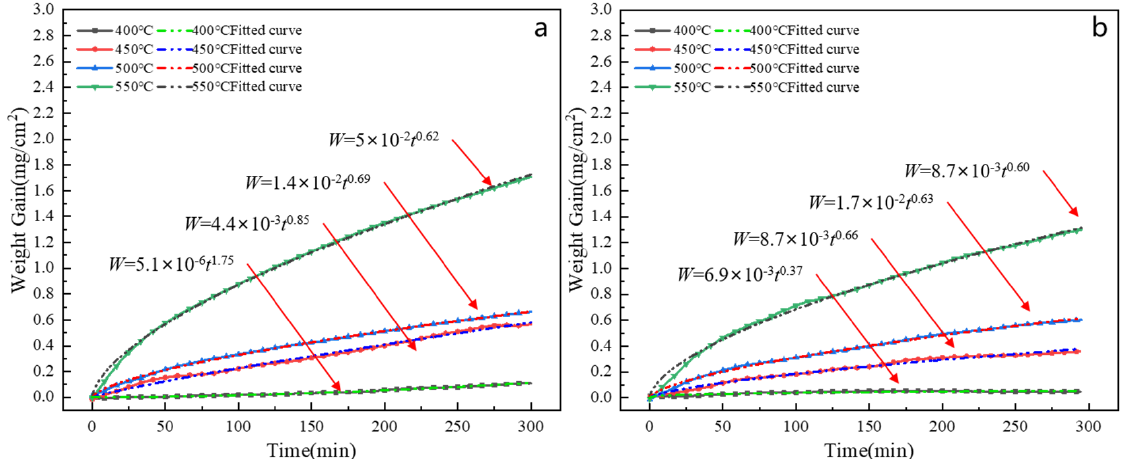
Figure 5. The curve fitting of oxidation weight gain after oxidation of alloy ( a )Al − 2Li, ( b )Al − 2Li − 0.2Sc.